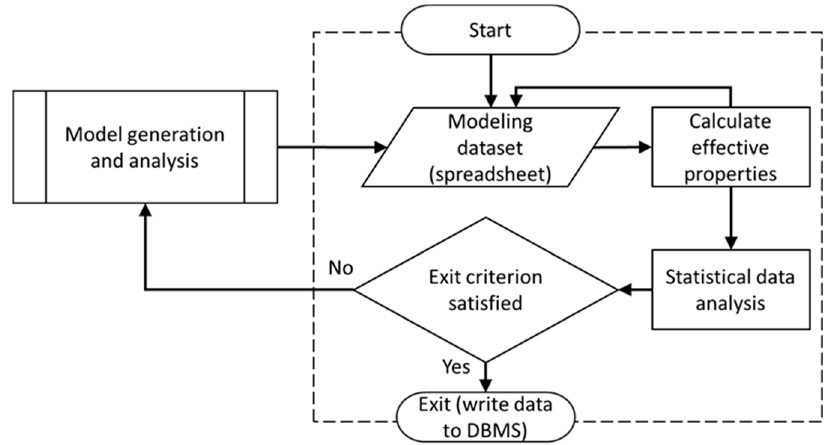
Figure 2. A schematic illustrating the algorithm for the Monte Carlo Simulation (MCS) module [58].